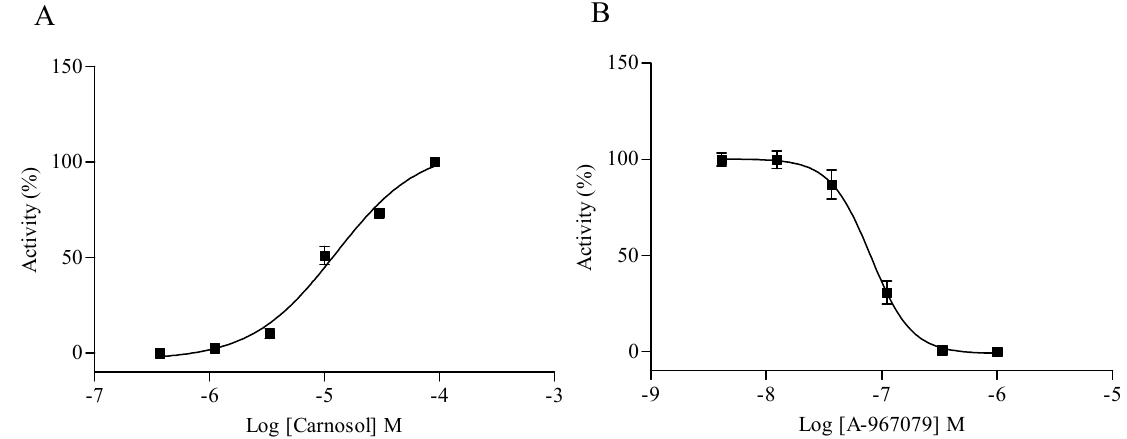
Figure 7. Hit verification in HEK293/TRPA1 cell line. ( A ) Concentration-response curves of carnosol in HEK/TRPA1 cell line. The EC 50 of carnosol was 12.46 µM; ( B ) Concentration-response curves of A-967079 (evoked by 30 µM carnosol). The IC 50 value of A-967079 was 80.70